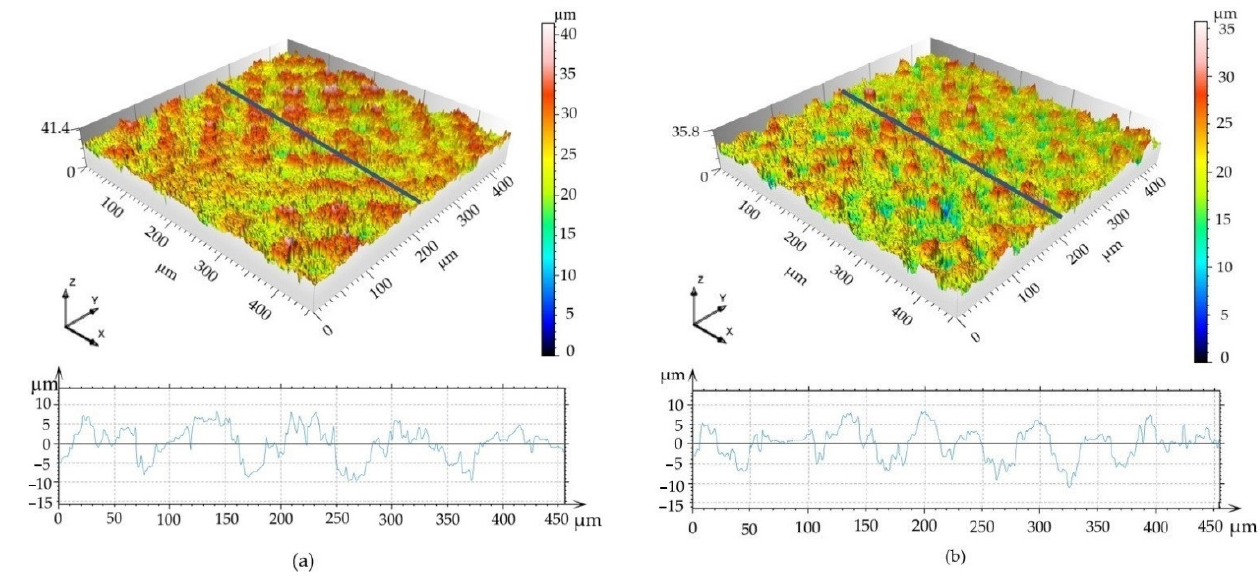
Figure 6. 3D surface maps. ( a ) Surface A; ( b ) Surface B.